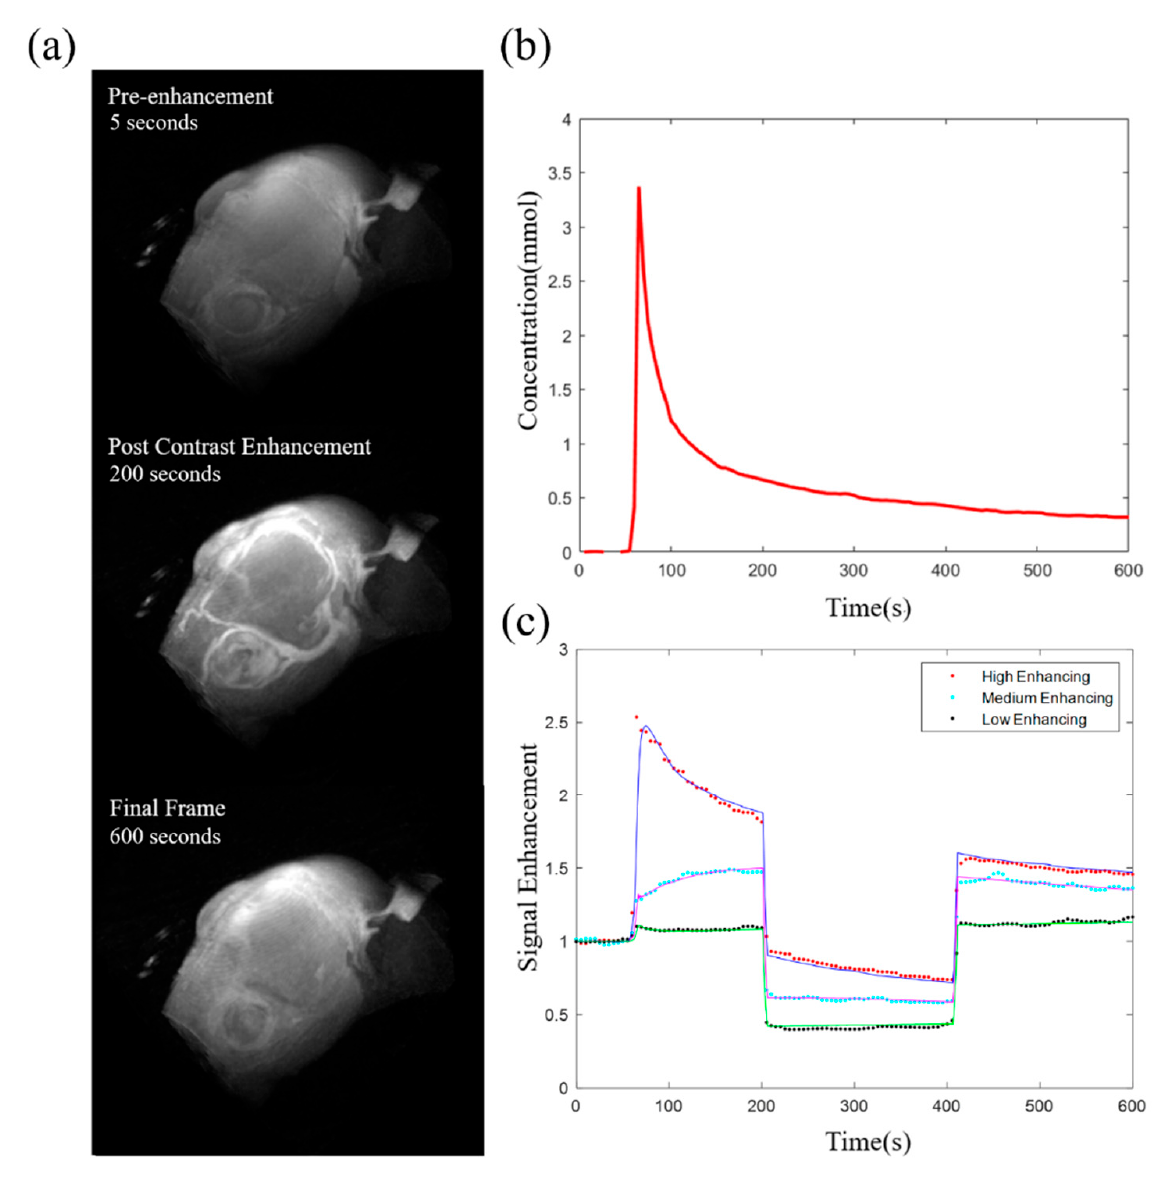
Figure 1. Example of acquired data from the 3D Dynamic Contrast-Enhanced (DCE) MRI. ( a ) Max- imum intensity projections of whole head T 1 weighted DCE MR images for pre-contrast (5 s), early phase of post-contrast (200 s; 140 s post-contrast injection) and final frame (600 s). ( b ) Arterial input function derived from early enhancing vascular voxels selected with the Principal Component Anal- ysis method. ( c ) Time intensity curves of three example tumor voxels with different enhancement levels (dotted lines), fitted with the two-compartment model and the three-site-two-exchange model (solid lines). The K trans values estimated from the model fit are 0.1043, 0.0559, and 0.0051 min − 1 for the high, medium, and low enhancing voxels, respectively.